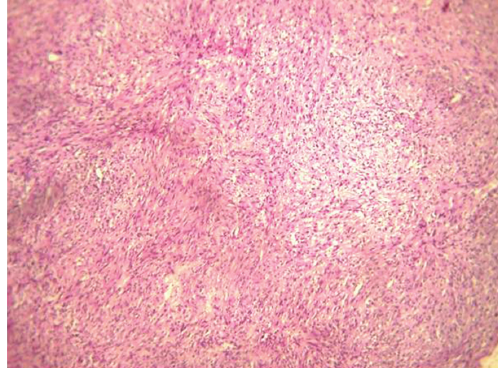
Figure 4: Photomicrograph showing high cellularity, intense proliferation of spindle-shaped cells and variable deposition of collagen (10x